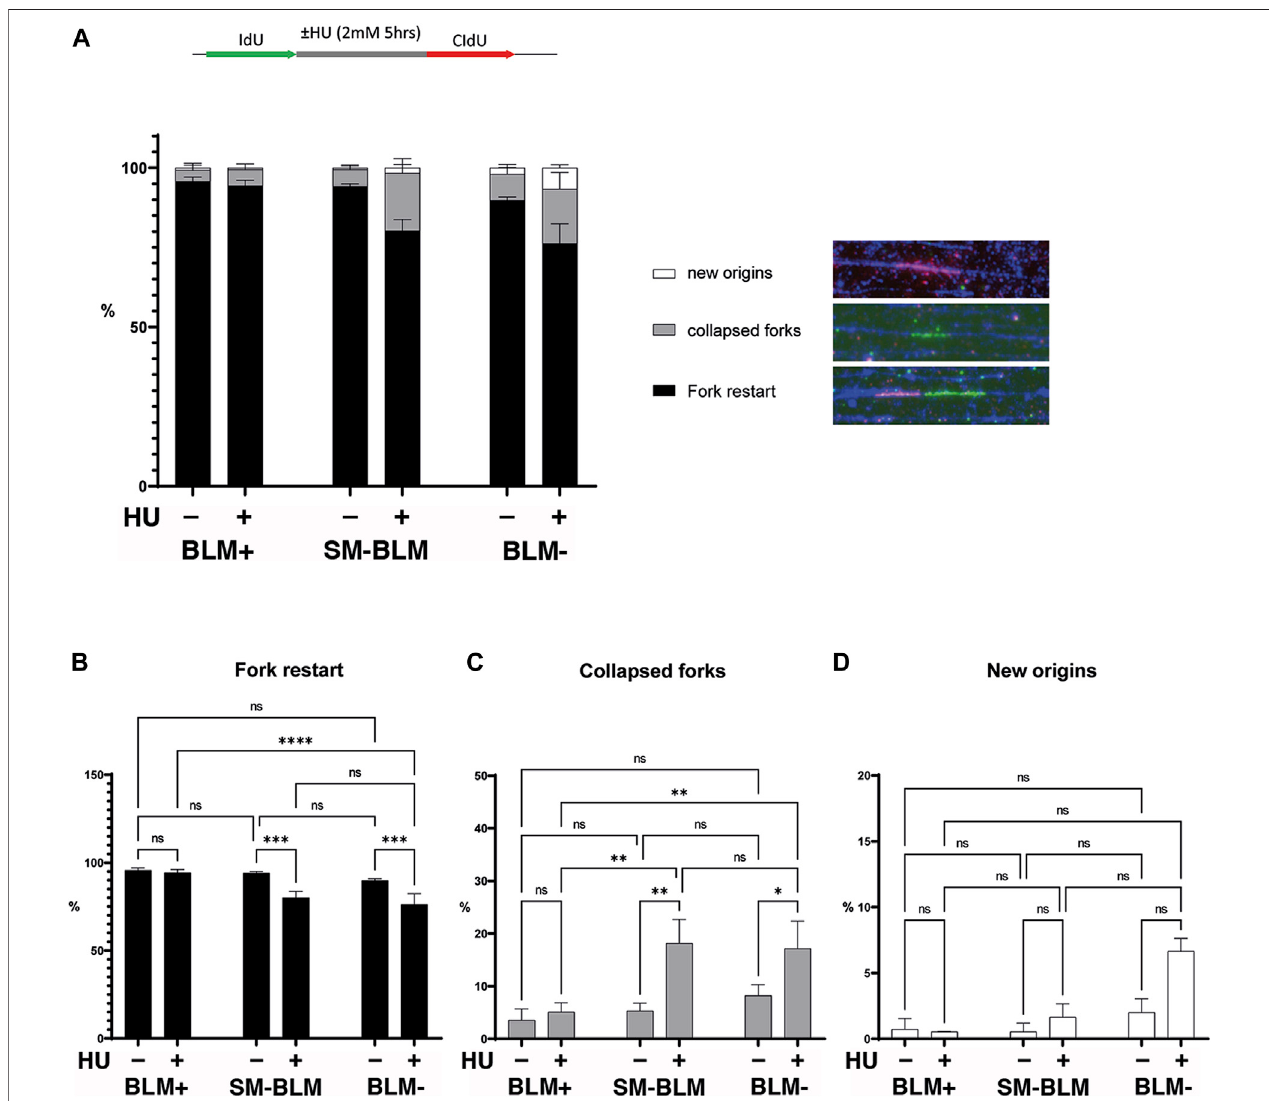
FIGURE 1 | SUMO-mutant BLM failed to restart some stalled forks under replication stress. As shown in the schematic image, cells were pulse-labelled with IdU, followedornotbya5-htreatmentwithHU,and fi nallyreleasedintomediacontainingCldU,afterwhichmaRTAwasperformed. (A) Signalscorrespondingtoforkrestart, collapsed forks, and new origin fi ring were scored and expressed as a percentage of total signals. Over 600 signals per condition were analyzed. Two independent experiments were performed, and mean and standard deviation are shown. Data were analyzed using ordinary two-way ANOVA followed by Tuckey ’ s multiple comparisontest Correspondingstatistical signi fi cancesareindicatedforeachgroup plottedindividually: forkrestart (B) ,collapsed forks (C) ,andneworigins (D) (ns,not signi fi cant; *, p < 0.05; **, p < 0.01; ***, p < 0.001; ****, p < 0.0001). Full statistical analysis is provided in Supplementary Table S1 and primary data is provided in Supplementary Data S1